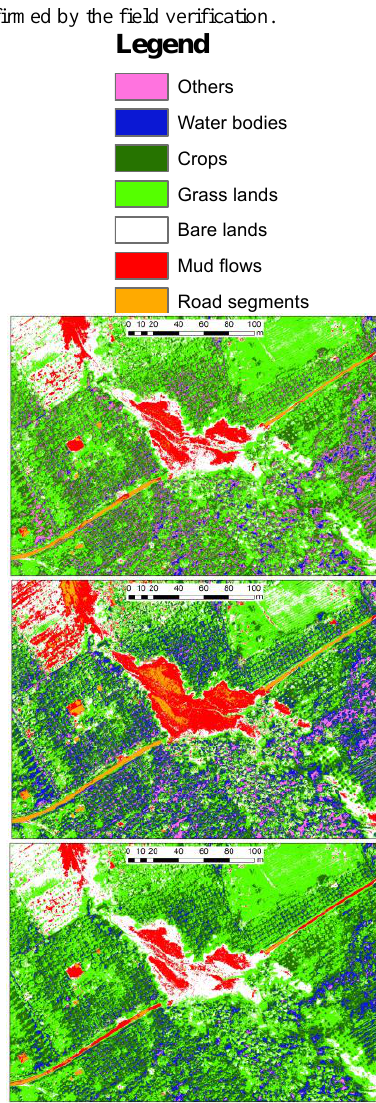
Figure 6: Classification Results (upper: Fuzzy K-Means, middle: Isodata, lower: